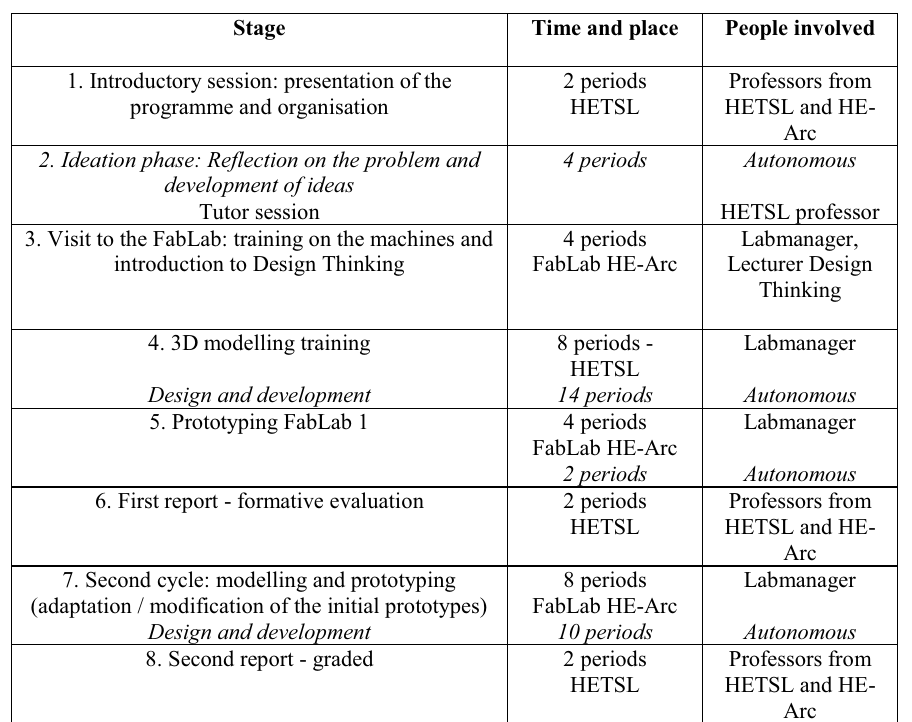
Table 1. Module description (in italics the autonomous